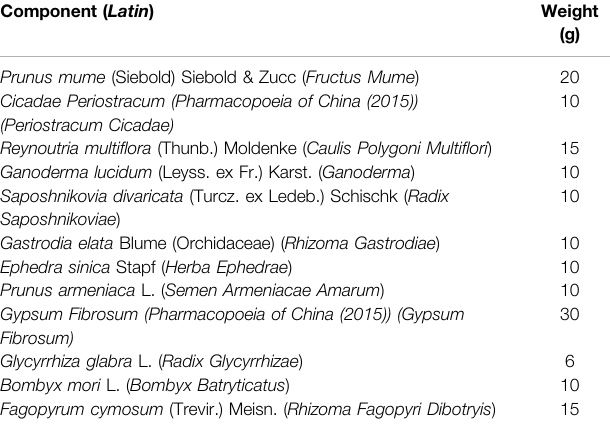
TABLE 1 | TMDCD composition. Component ( Latin ) Weight